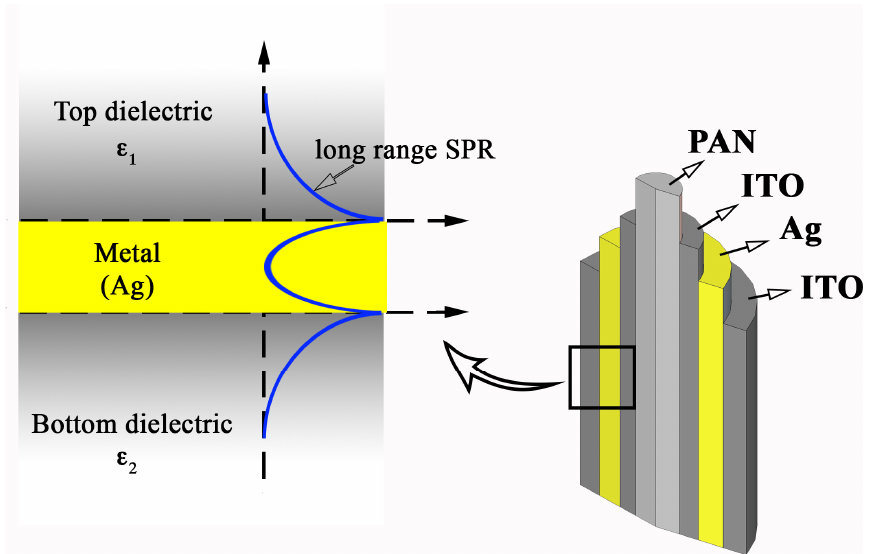
Figure 4. The decay of a surface plasmon excitation at the double metal semiconductor interface and generation of long range SPR within hybrid